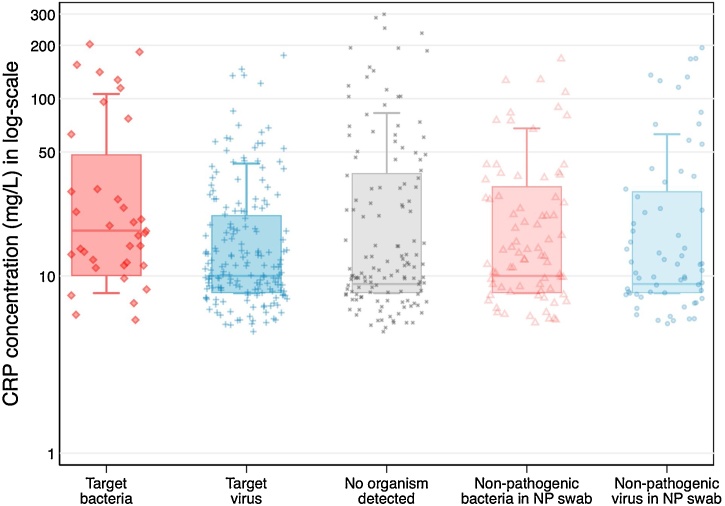
C-reactive protein (CRP) concentration (mg/L) using a log scale per aetiological group in Chiang Rai, northern Thailand and Hlaing Tha Yar, Lower Myanmar, 2016–2017.CRP concentrations (all in log-scale) are coloured in blue for viruses, red for bacteria and in grey when no organisms were detected neither in blood specimens nor in nasopharyngeal (NP) swabs.Box boundaries show 25th and 75th percentiles of CRP concentrations and lines within the boxes show the medians.The whiskers indicate the 10th and 90th percentile of CRP concentrations.